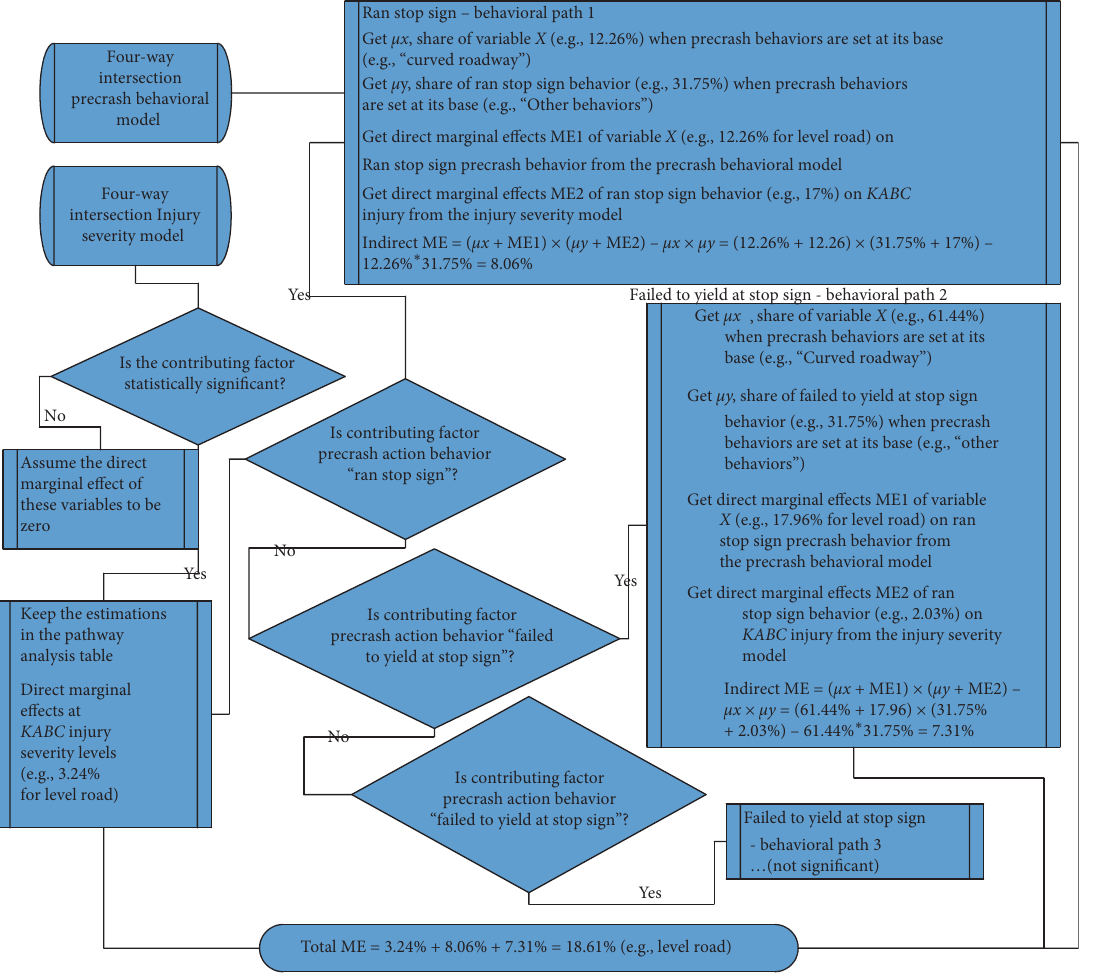
Figure 2: The logical procedure to calculate the total marginal effects based on the direct marginal effects through the injury severity model and the indirect marginal effects through the precrash behavior